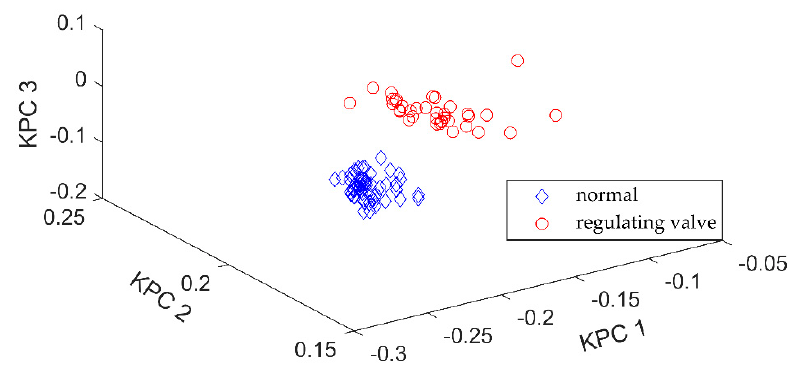
Figure 5. The clustering result using K-means.